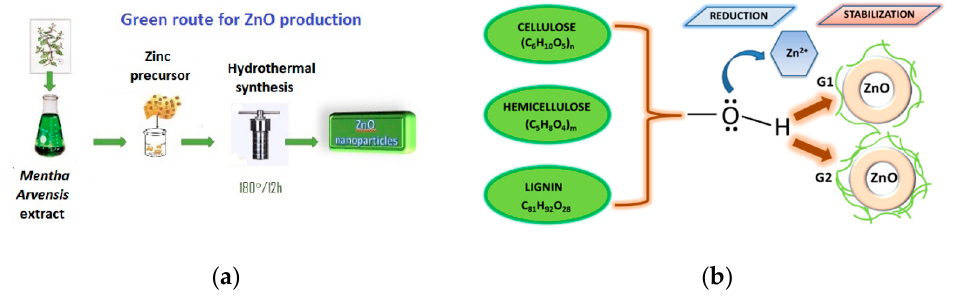
Figure 1. Experimental scheme of bio-mediated ZnO powder preparation—( a ); scheme illustrating the reducing/stabilizing role of the Mentha arvensis extract—( b